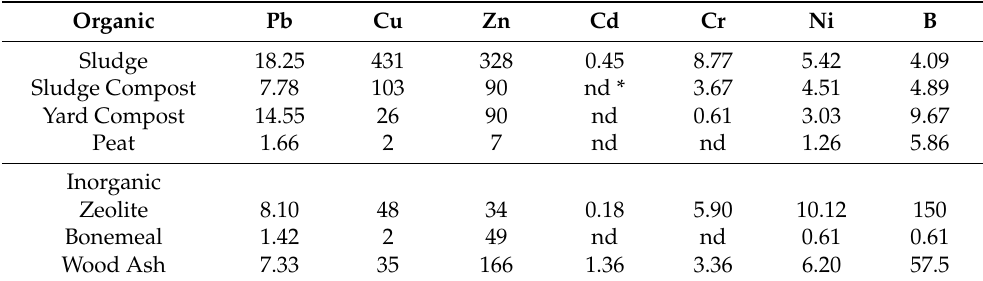
Table 3. Mean elemental (mg kg − 1 ) composition of applied immobilization